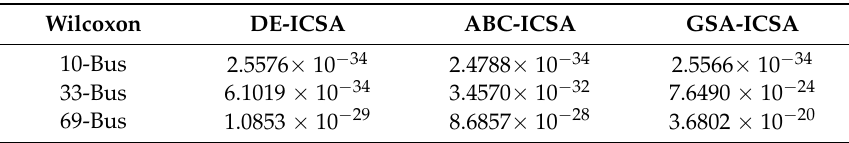
Table 15. Statistical